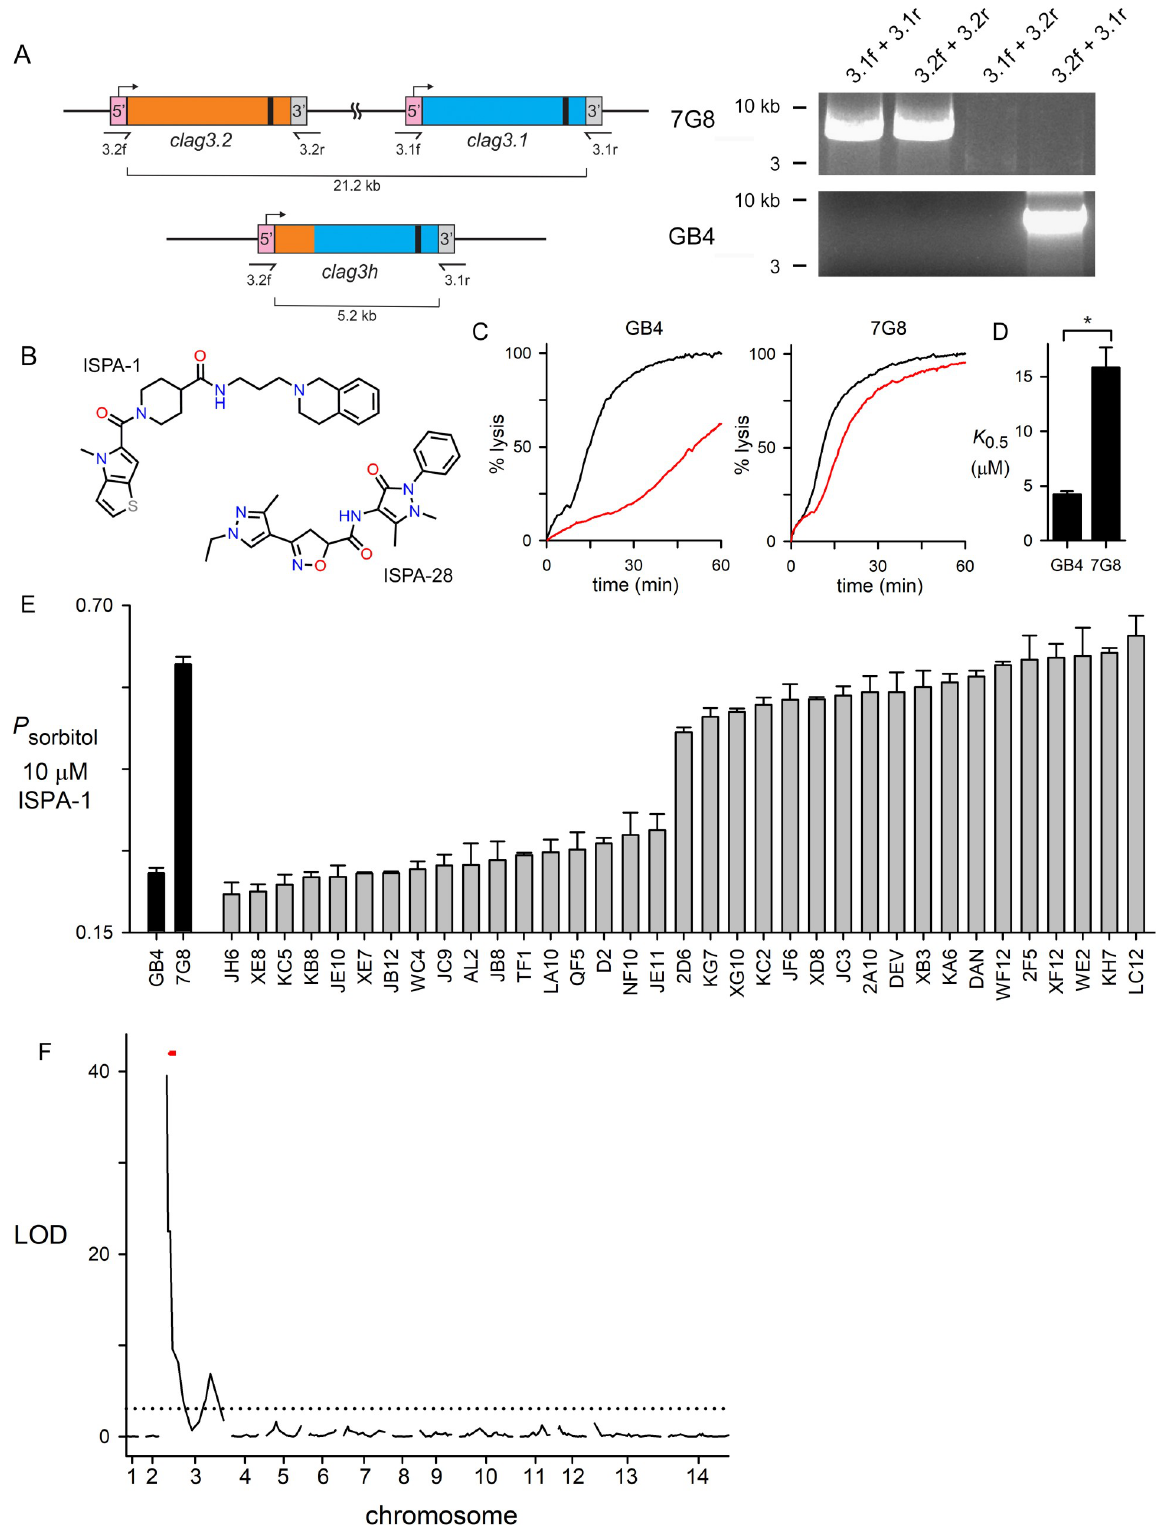
Fig 1. Mendelian inheritance of a PSAC phenotype in the GB4 x 7G8 cross. (A) Schematic showing the two clag3 genes in 7G8 and a single clag3h in GB4; gene ribbons are color-coded to show site of recombination to produce copy number reduction in GB4. Black bar near the 3’ end